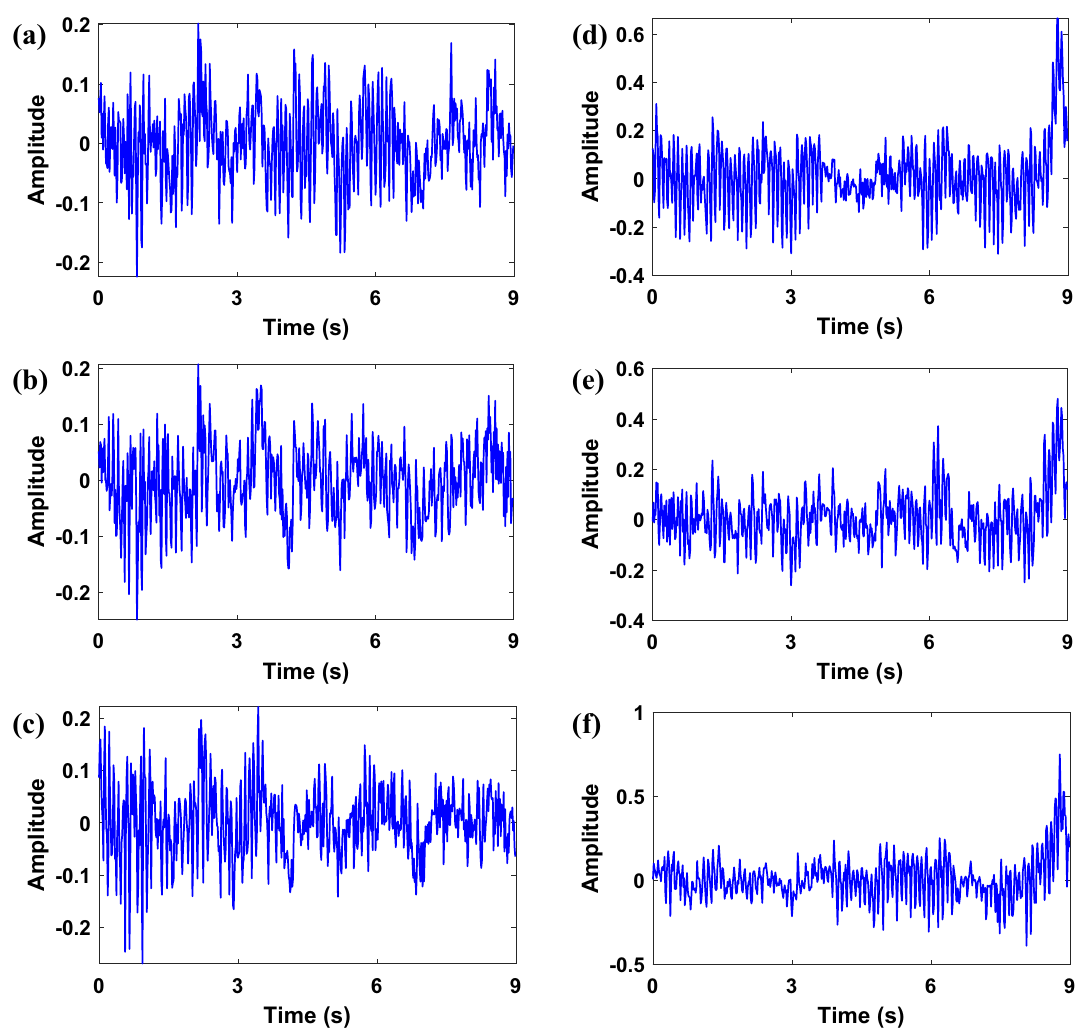
Figure 3. EEG signals from dataset II–III recorded during different tasks. ( a ) C3 channel of left-hand motion, ( b ) C4 channel of left-hand motion, and ( c ) Cz channel of left-hand motion, ( d ) C3 channel of right-hand motion, ( e ) C4 channel of right-hand motion, ( f ) Cz channel of right-hand